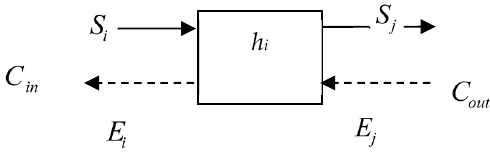
Figure 1. A stepping-stone host.